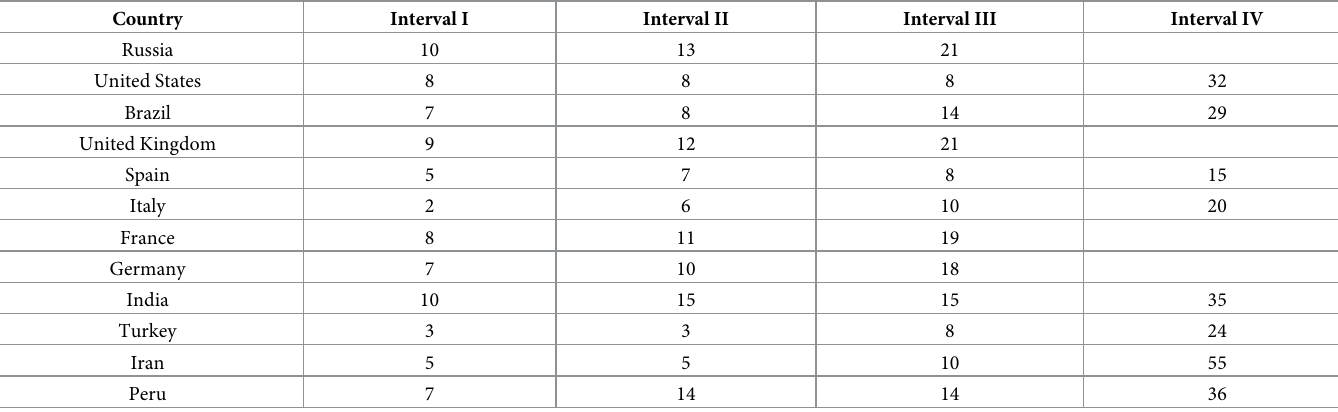
Table 3. Temporal intervals for the most infected